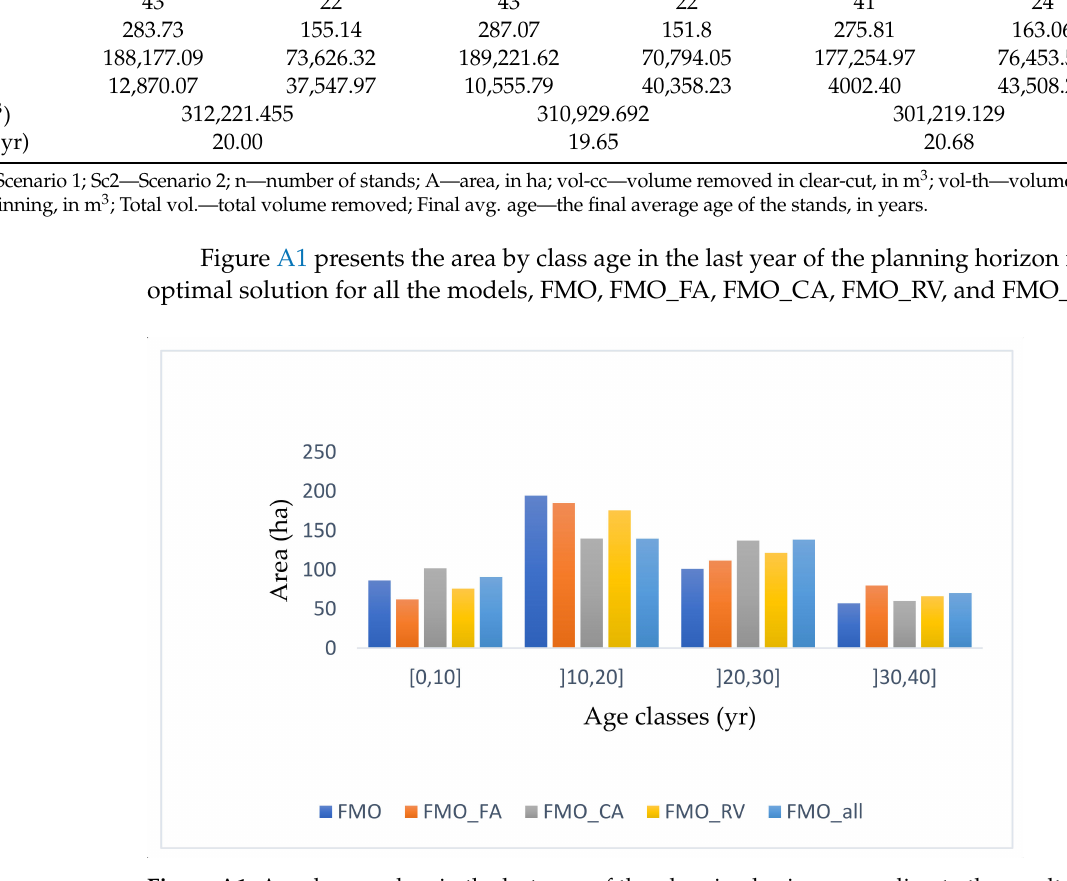
Figure A1. Area by age class in the last year of the planning horizon according to the results of all